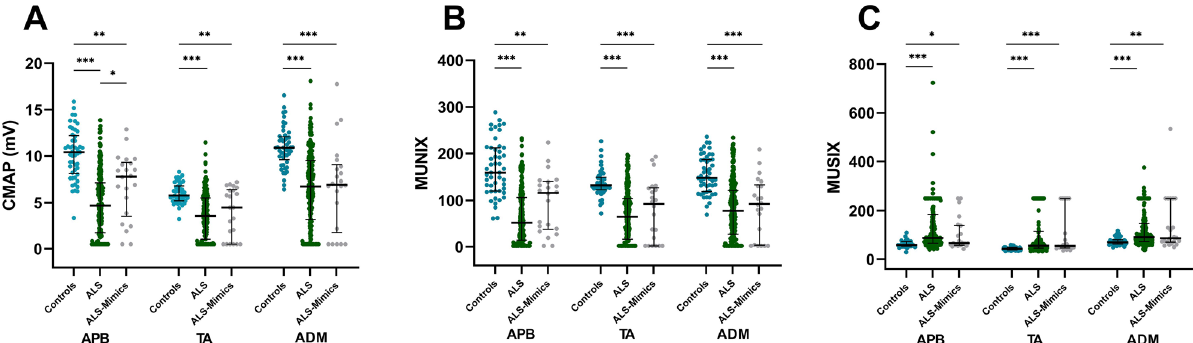
Figure 3. Scatterplots of CMAP ( A ), MUNIX ( B ) and MUSIX ( C ) of APB, TA and ADM of the three different groups. Bars indicate median and interquartile range. *p < 0.05, **p < 0.01, ***p < 0.001. Comparisons with Kruskal–Wallis test, pairwise comparisons with Bonferroni correction. ADM abductor digiti minimi, ALS amyotrophic lateral sclerosis, APB abductor pollicis brevis, TA tibialis